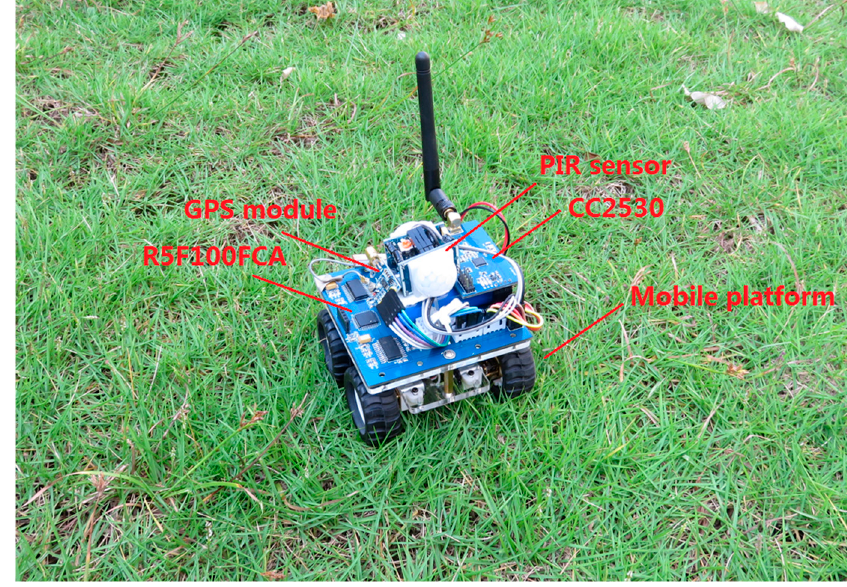
Figure 10. ( a ) Average energy consumption and detection rate for different representative coefficients γ ; and ( b ) detection rate for different learning speed coefficients η .